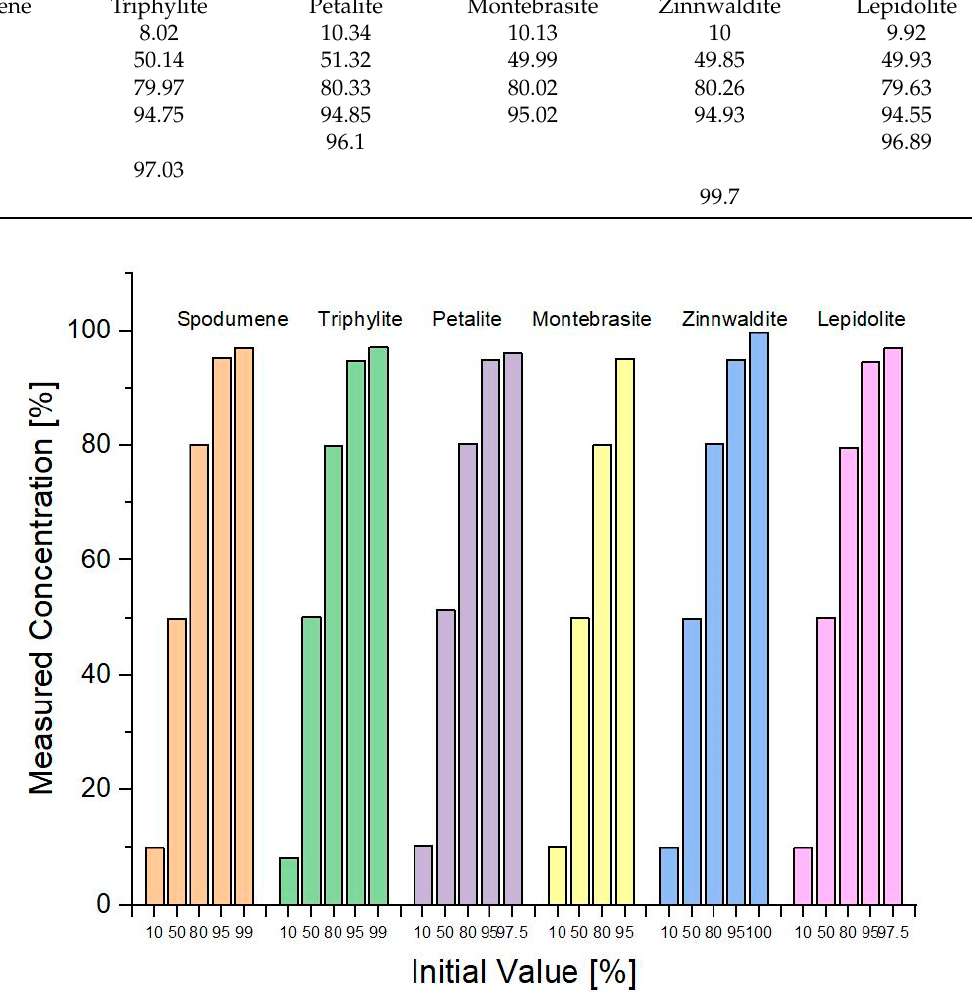
Figure 46. Measurements and results of typical concentrates of the lithium minerals and the measured contents deter- mined by